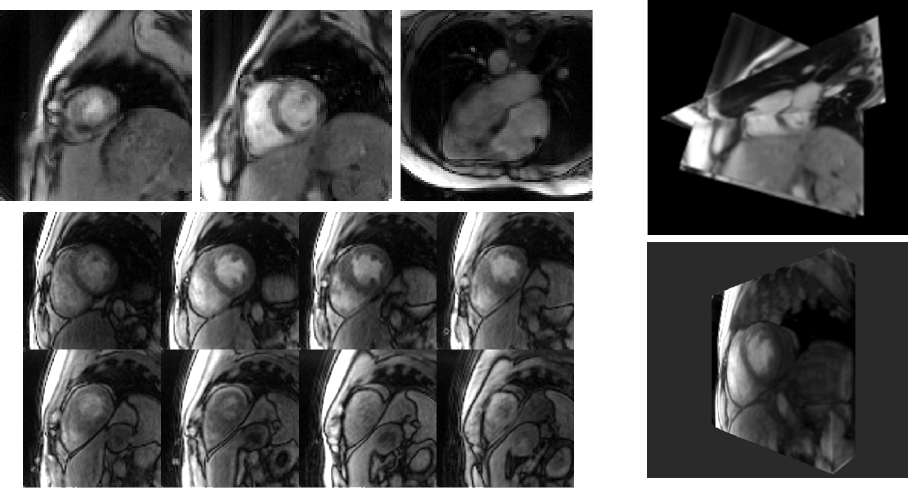
Figure 7. Example 2D panel display and corresponding renderings. ( Top left ) Three slices in short- axis and four-chamber views. Note that the dark bands across the ventricles in the four-chamber view are from saturation of the signal where the short-axis slices intersect. ( Top right ) Rendering of the slices in the correct spatial positions and orientations. ( Bottom left ) Panel display of eight partitions in a volumetric dataset centered over the left ventricle. ( Bottom right ) Rendering of the